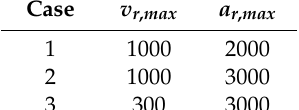
Table 3. Maximum velocity and acceleration of robot.